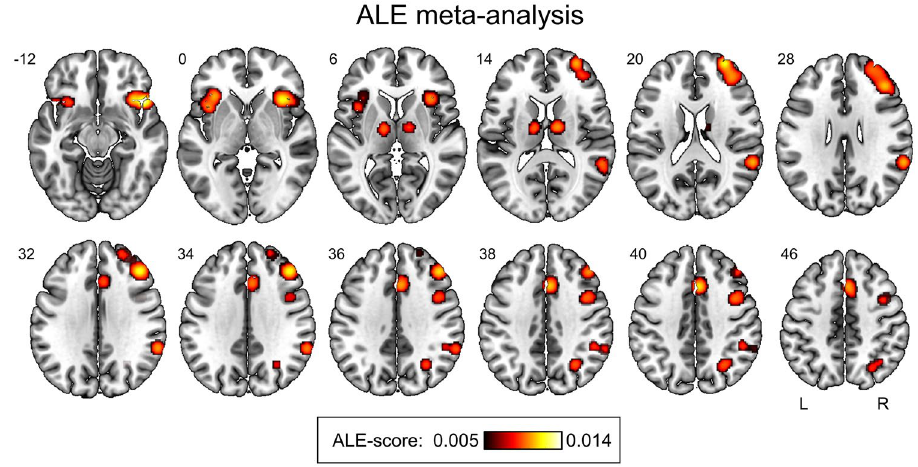
Figure 3. Results of the ALE meta-analysis. The result of the meta-analysis of 20 fMRI studies using equal probability Go/NoGo tasks (“50/50% Go/NoGo blocks > 100% Go-control blocks” contrast). Figure was created using MRIcroGL 1.2.2 software (https:// www. nitrc. org/ proje cts/ mricr ogl).